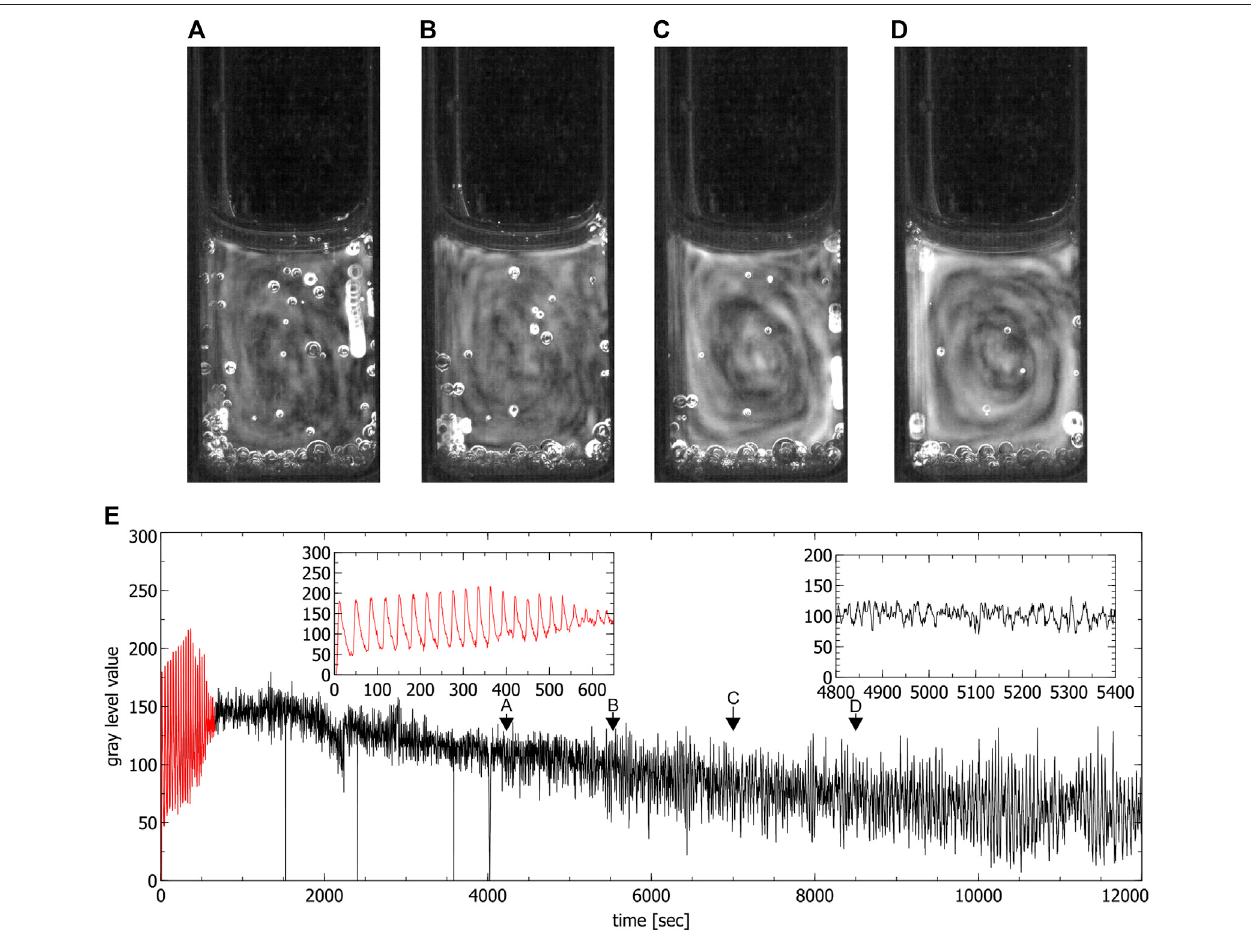
FIGURE 6 | Convection cells in a partly fi lled standard cuvette during the chaotic phase. (A – D) show the presence of one convection cell (liquid moves anti- clockwise). Images were obtained by averaging over 60 s, (E) is the time series extracted from the video data where the red part corresponds to the periodic phase. Insetsshowtheperiodicphase(left)andpartofthechaoticphase(right)magni fi ed(spikesinthetimeseriescorrespondtothepassageofbubbles).Arrowsindicatetimes where the images (A – D) were created.